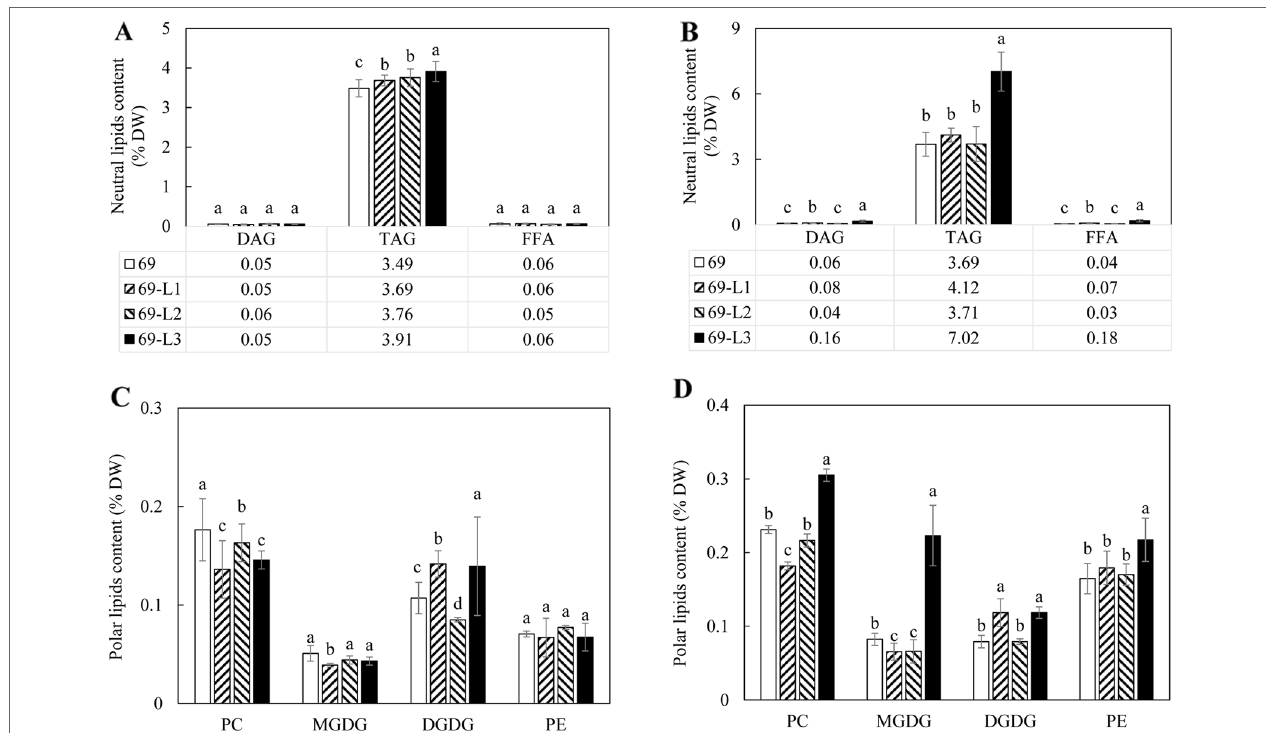
FigURE 6 | Contents of neutral and polar lipids in the potato tubers of the HO69 (open bars) and three super-transformed lines, 69-L1 (bar with upward trend), 69-L2 (hatched bars) and 69-L3 (black bars) at two developmental stages. (A) Neutral lipids contents at the flowering stage; (B) Neutral lipids contents at the mature stage; (c) Polar lipids contents at the flowering stage; (D) Polar lipids contents at the mature stage. The data represent the mean values ± SD of three biological replicates. Letters (a, b, c) above the bars are based on LSD, bars marked with different letters are statistically significantly different at P <